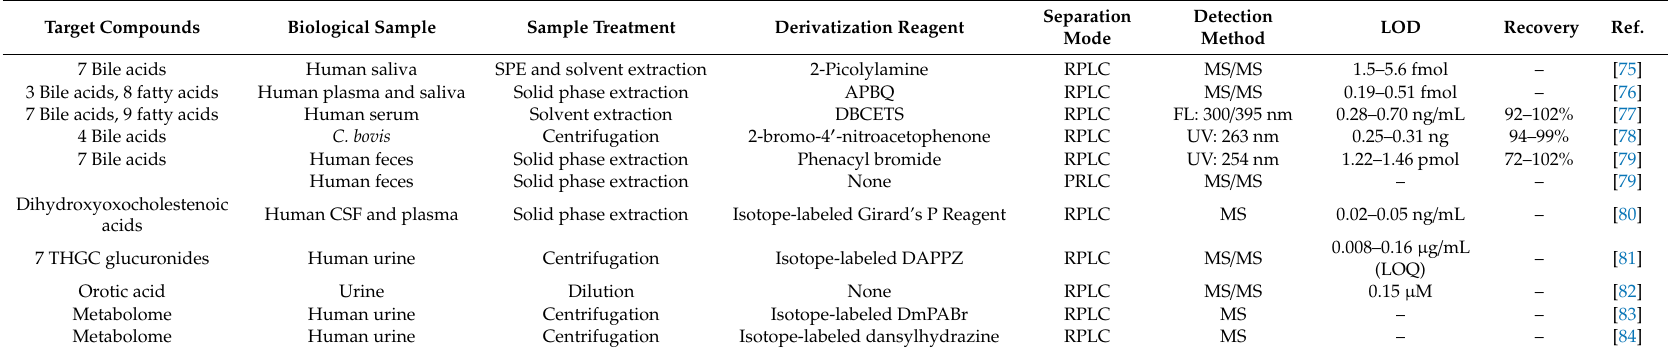
Table 7. Analytical methods for other carboxylic acids in biological